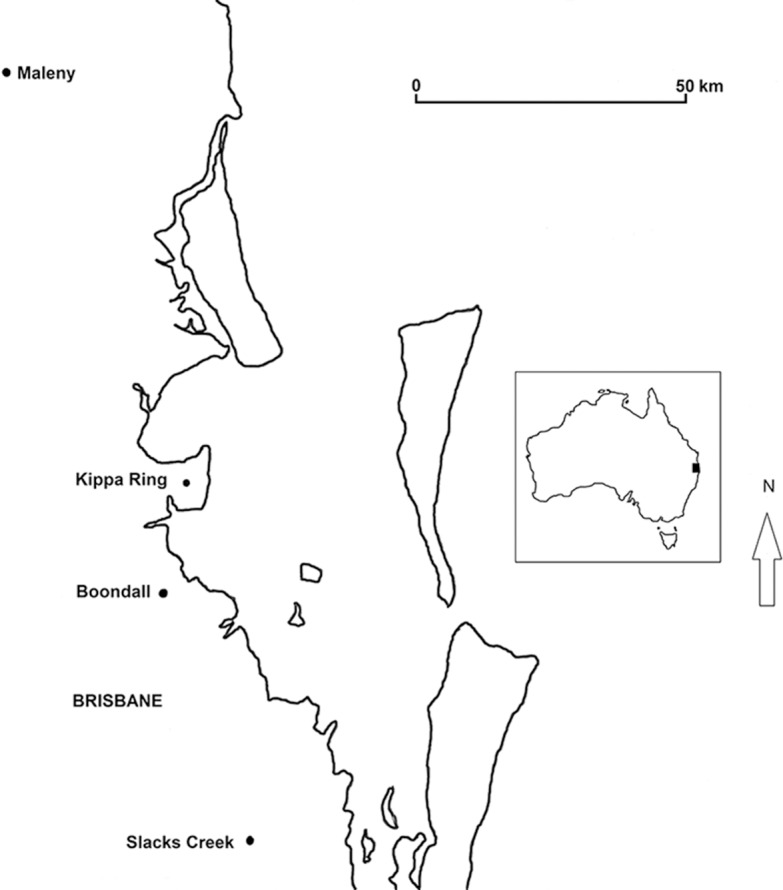
Schools locations.